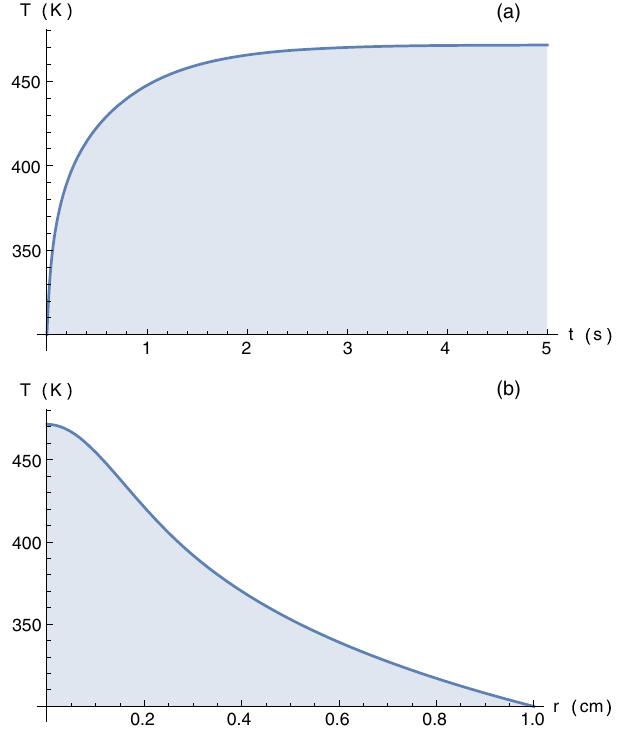
FIG. 16. (a) Temporal evolution of the collimator temperature (computed at radial position r ¼ R ) during the interaction with h the driver beam. (b) Radial evolution of the collimator temper- ature computed at time t ¼ 5